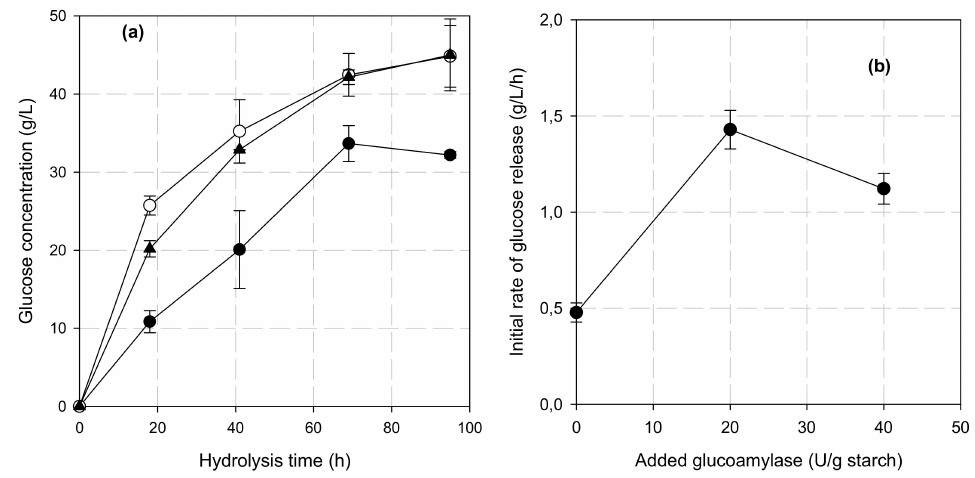
Figure 2. ( a ) Time course of glucose release during FW hydrolysis by F. oxysporum F3 multienzyme system ( • ), supplemented with 20 ( ), 40 ( (cid:78) ) Units / g starch Spirizyme ® Fuel. ( b ) Initial rate of (cid:35) glucose release.